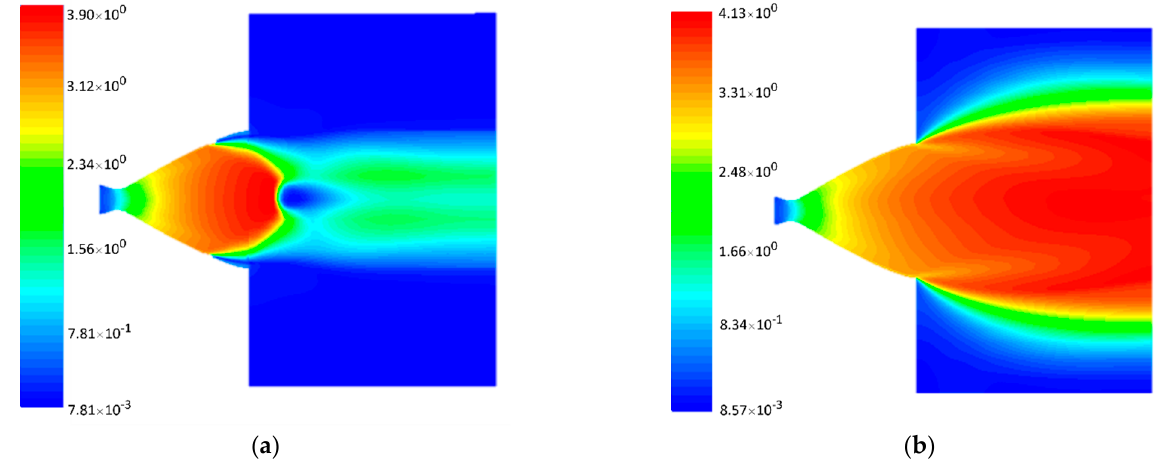
Figure 19. Pc = 6 MPa. The cloud map of ground and high altitude. ( a ) Ground. ( b ) High altitude.